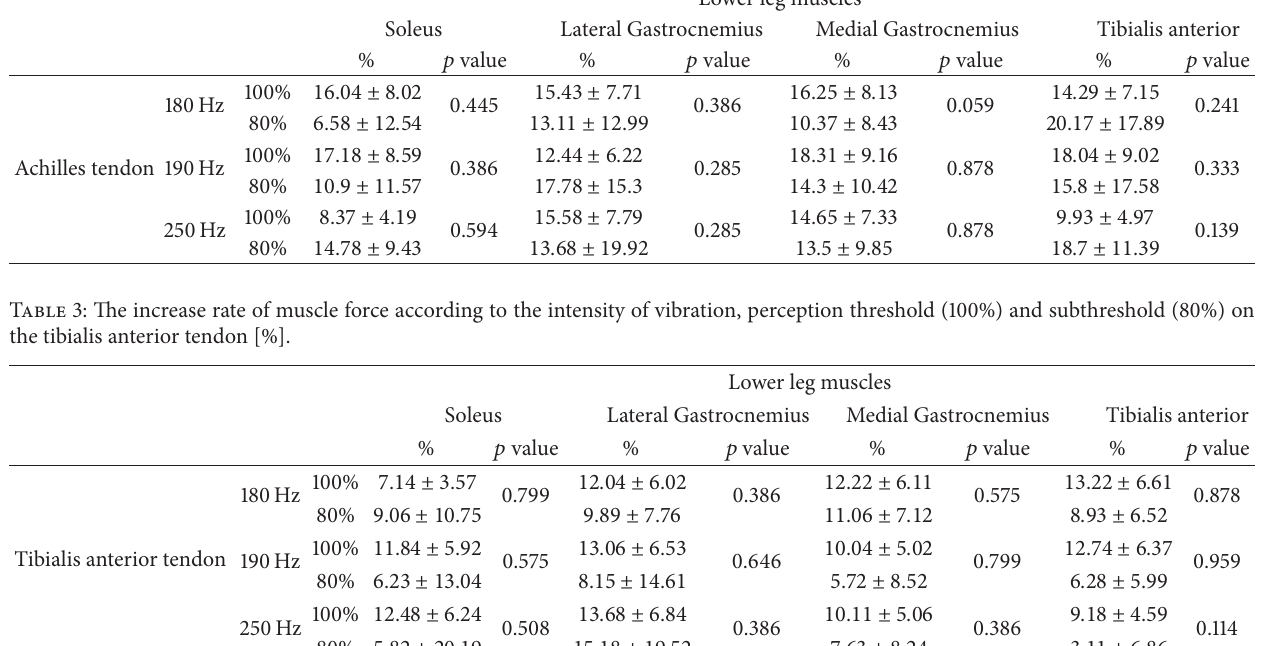
Tibialis anterior tendon